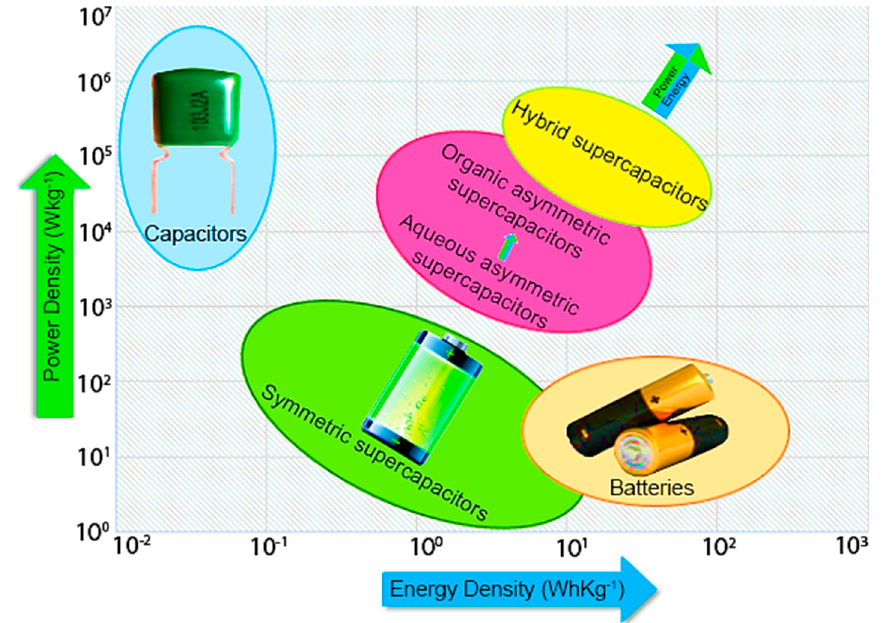
Figure 1. Ragone plot of the power-energy density range for different electrochemical energy storage devices.